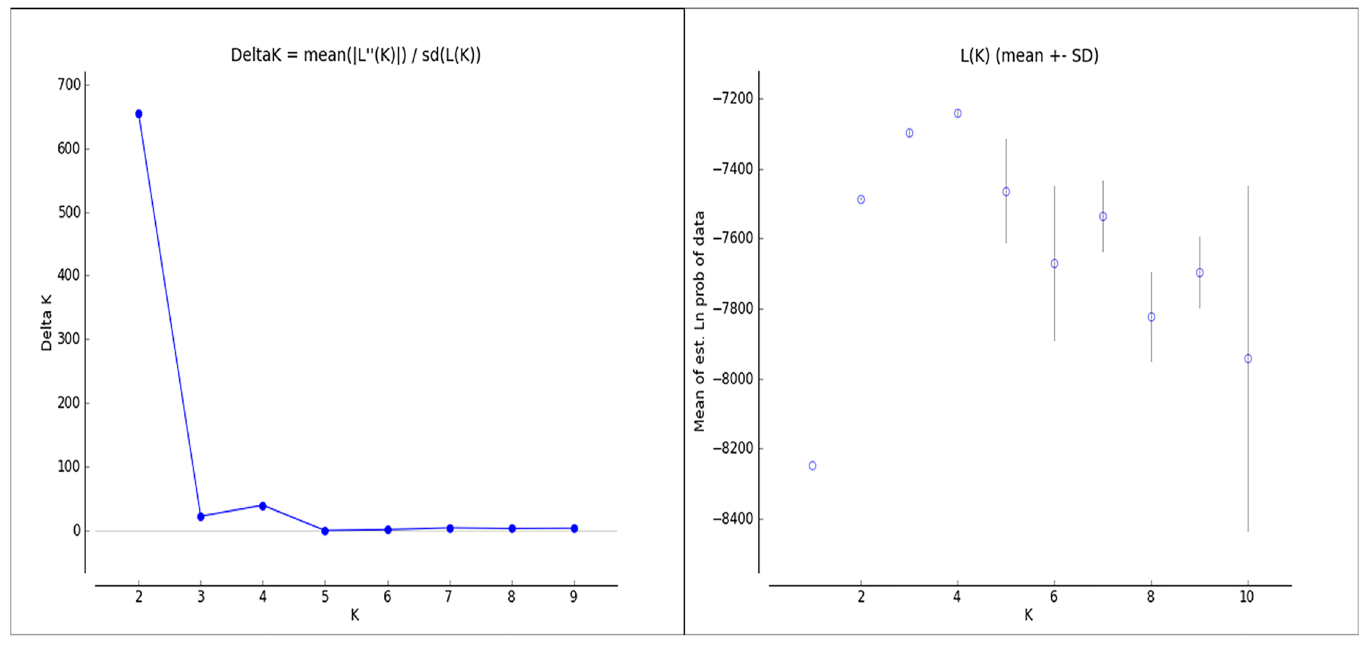
Fig 4. Delta K and the mean of estimate natural log probability of STRUCTURE runs of T . albacares samples using values of K = 1 to K =